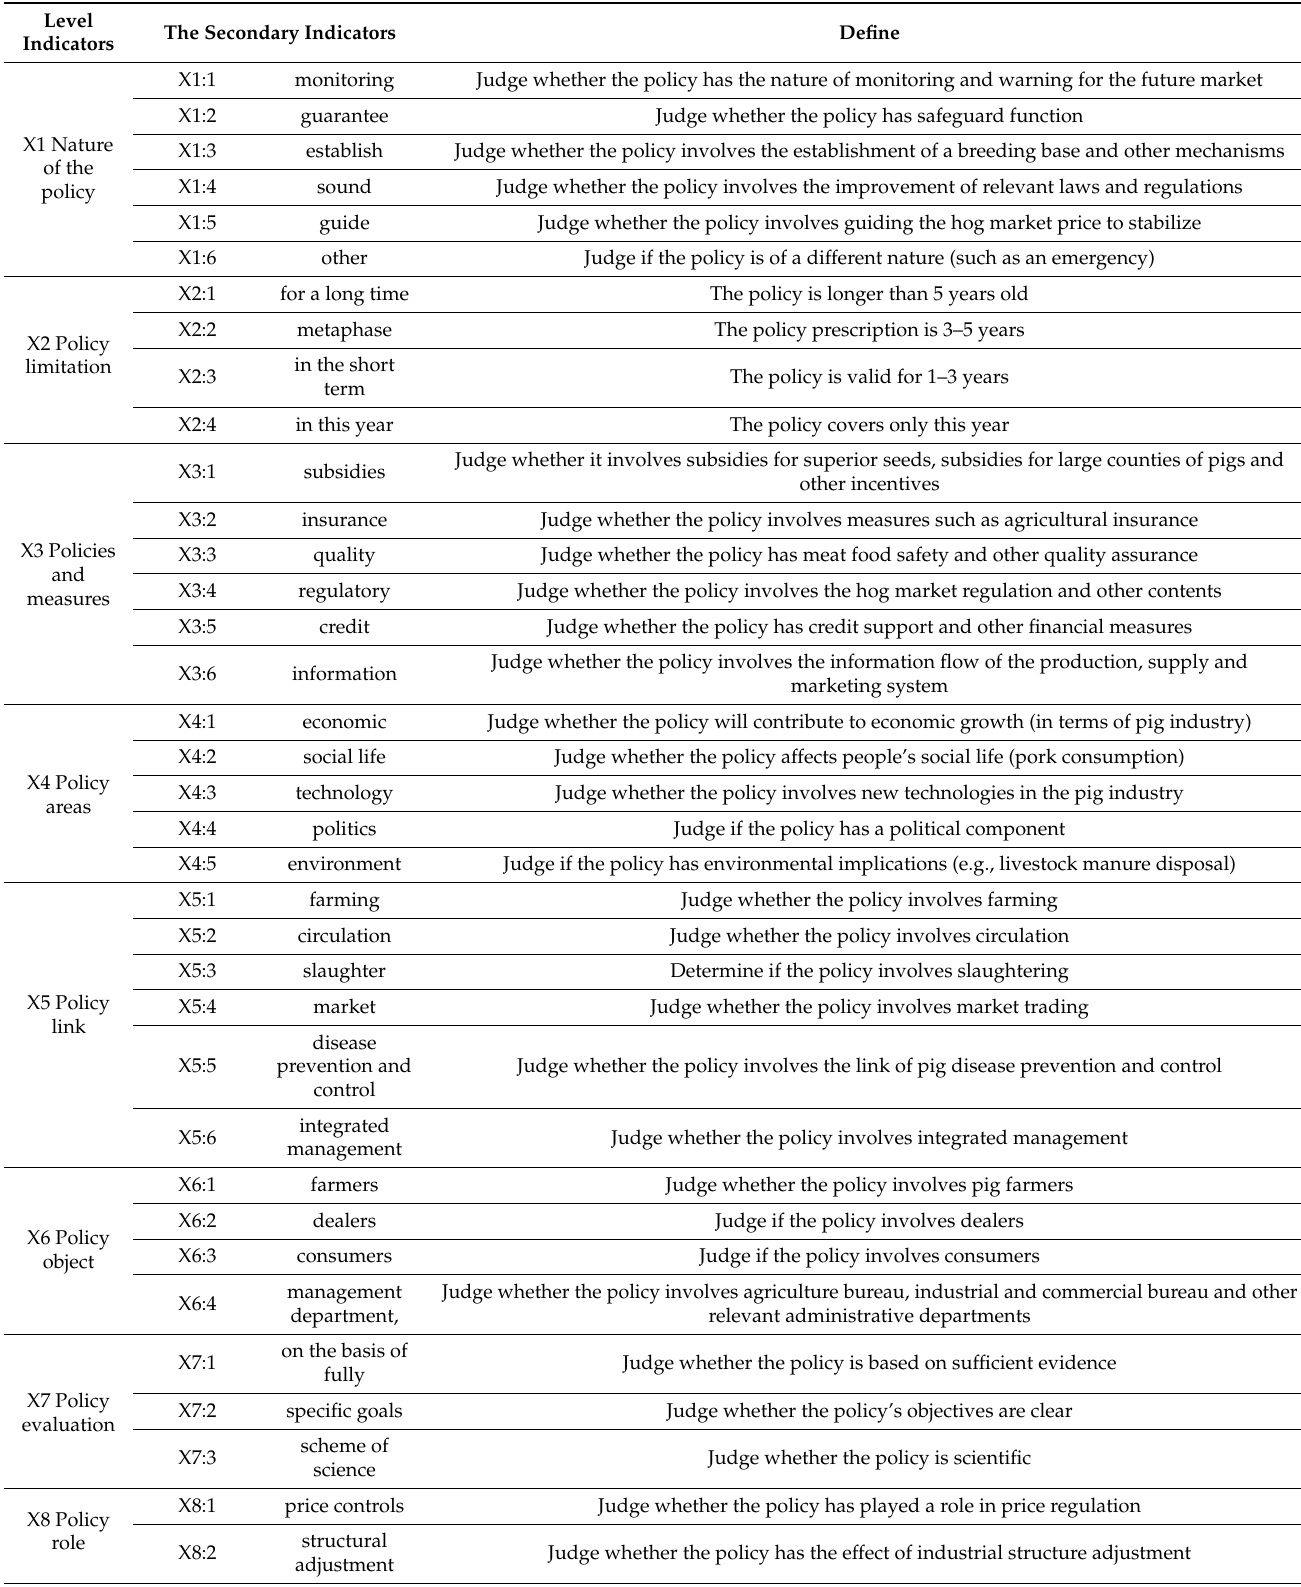
Table 4. Comparison Table of China’s Pig price control Policy Variables and Indexes. Level